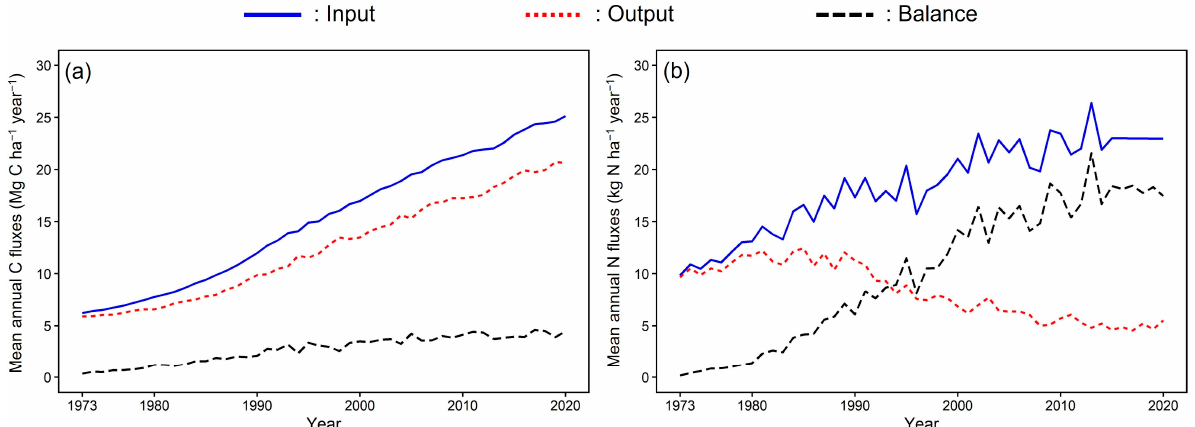
Figure 3. Dynamics of the simulated mean annual input, output, and balance of ( a ) C and ( b ) N across the South Korean forests from 1973 to 2020.